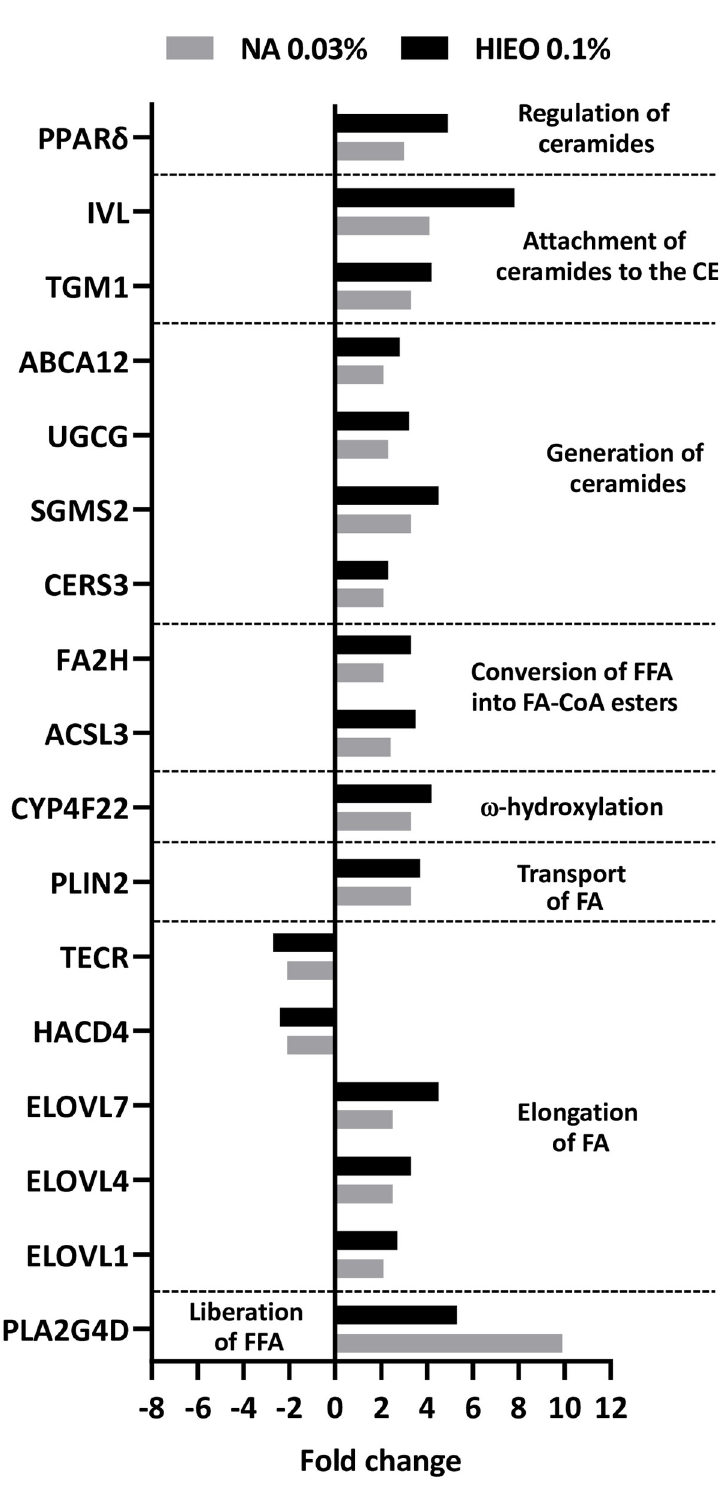
Fig 8. NA increased the gene expression of ceramide synthesis-related enzymes. Transcriptome analysis was performed with microarray using skin explant treated with NA (0.03%) or HIEO (0.1%) and a control group, DMSO (0.5%). Mean fold-change induced by HIEO and NA in quadruplicate explant for each donor from three distinct donors after 24-hour treatment are shown. The 1008 genes in common to HIEO and NA were analyzed with IPA software and an enrichment analysis of certain pathways allowed the identification of differentially expressed genes